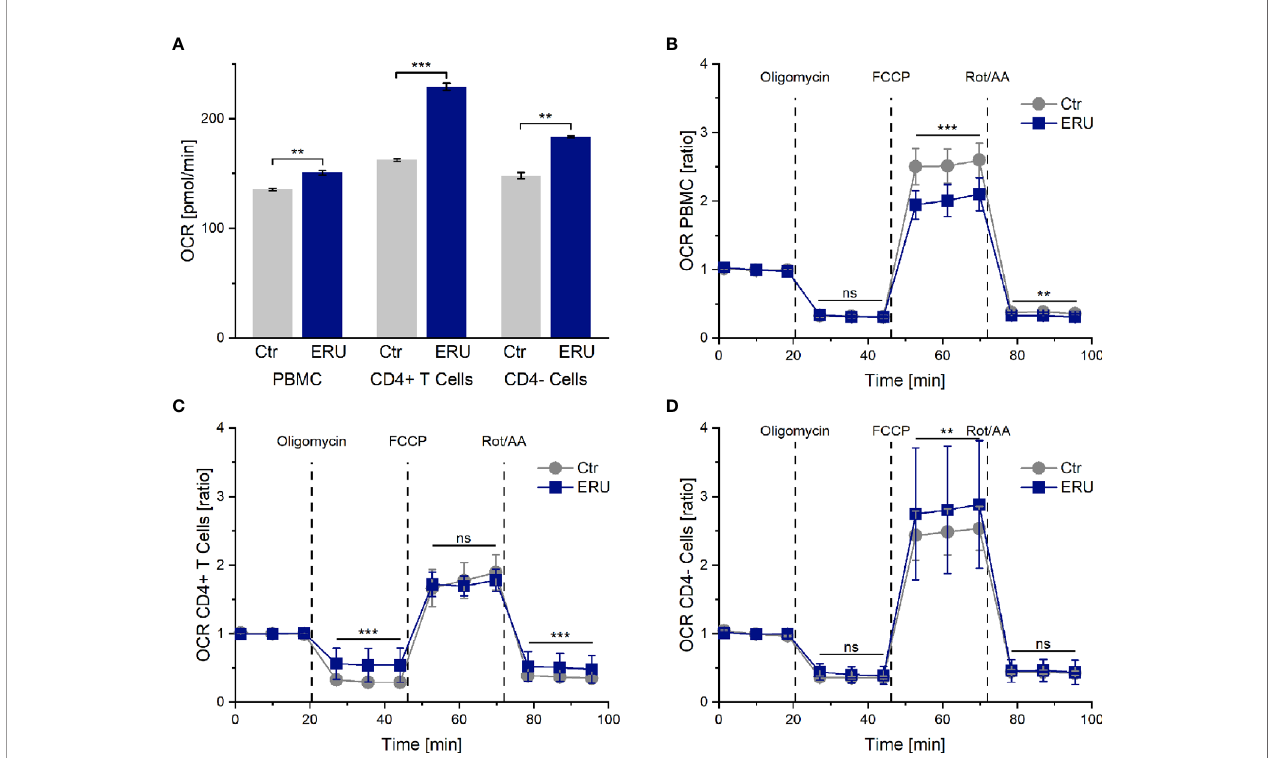
FIGURE 1 | Oxygen consumption rates (OCR) and OCR ratios by mitochondrial metabolism of PBMC, CD4 + T cells and CD4 - cells of healthy and ERU cases. Controls (n=16) are presented as grey lines whereas ERU cases (n=9) are illustrated as blue lines. OCR is shown by graph (A) and OCR ratios are illustrated by graphs (B – D) . First three measurements (dots) show basal respiration, followed by injections of oligomycin (after the third measurement point), FCCP (after the sixth measurement point) and Rot/AA (after the ninth measurement point). Data are shown as mean ± SEM. (A) Signi fi cantly higher basal oxygen consumption rates of equine PBMC (**p ≤ 0.01), CD4 + T cells (***p ≤ 0.001) and CD4 - cells (**p ≤ 0.01) of ERU cases compared to controls. (B) After normalization against the baseline mean, PBMC of ERU cases showed signi fi cantly lower OCR ratio after FCCP (***p ≤ 0.001) and Rot/AA (**p ≤ 0.01) injection compared to controls. (C) CD4 + T cells of ERU cases showed signi fi cantly higher OCR ratio (***p ≤ 0.001) when injected with oligomycin and Rot/AA. (D) CD4 - cells of horses with ERU had signi fi cantly increased OCR ratio (**p ≤ 0.01) after FCCP injection. No signi fi cant difference is represented by ns (ns p > respective OCR ratios as reaction to the injected substances between the two tested groups.